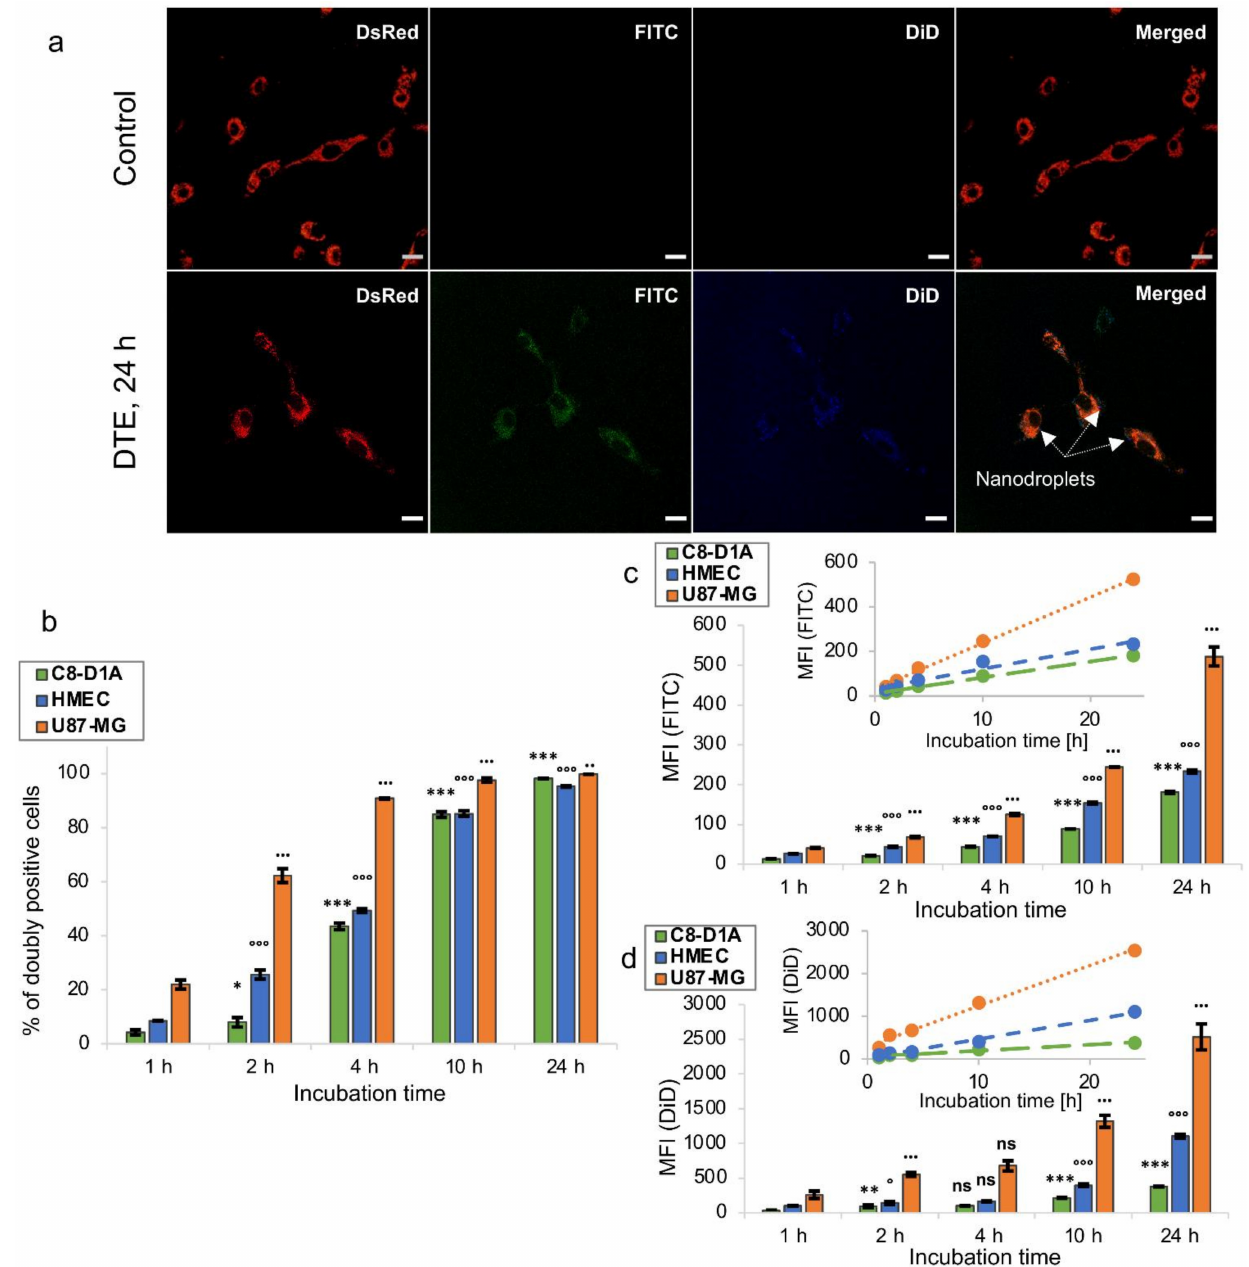
Figure 3. Cellular uptake of nanodroplets. ( a ) Confocal laser scanning microscopy imaging of U87- MG-transfected DsRed cells (red) untreated (control) or treated with DTE (green/blue, arrows) for 24 h. Scale bar = 20 µ m. ( b – d ) Fluorescence-activated cell sorting analysis of U87-MG, HMEC-1 and C8-D1A cells treated with DTE for 1, 2, 4, 10 or 24 h. The values are expressed as mean ± SD ( n =